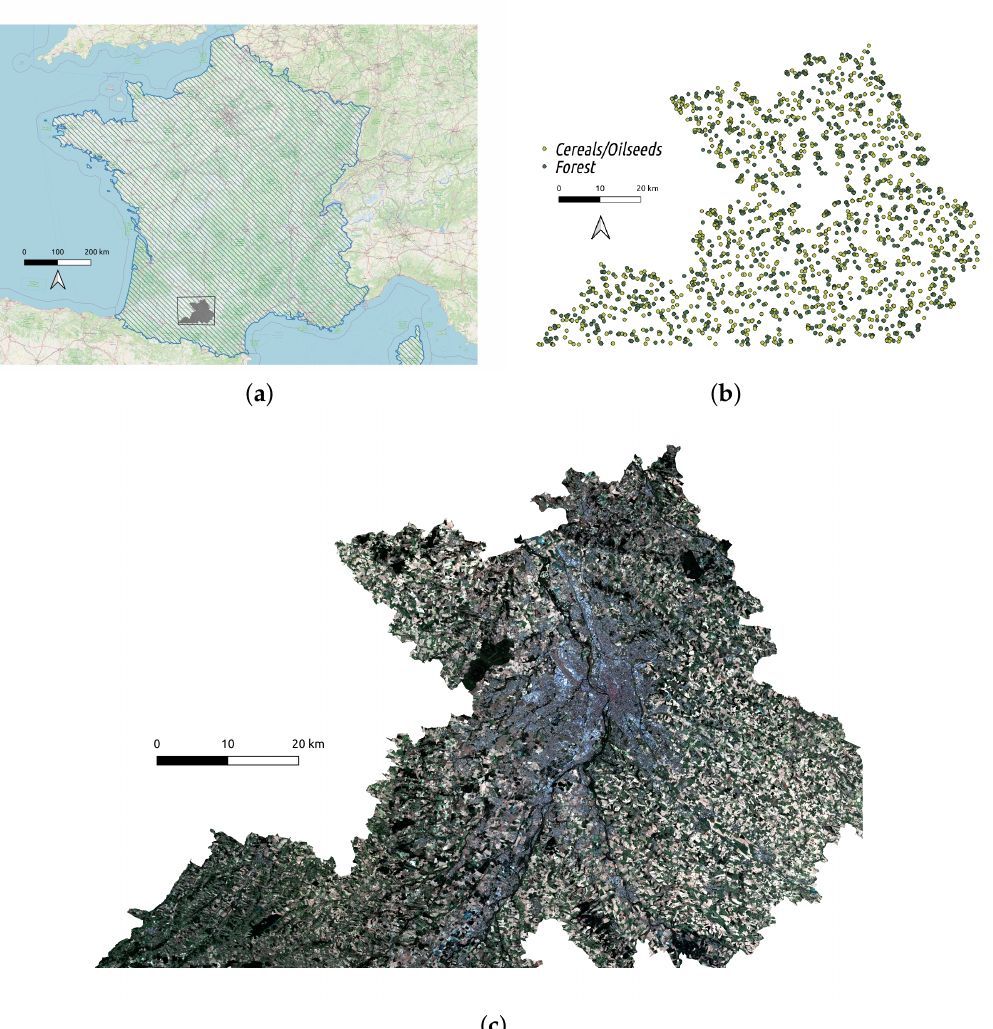
Figure 4. Haute-Garonne is located in the southwest of France ( a ). The spatial distribution of the land covers ( Cereals/Oilseeds and Forest ) considered as positive classes ( b ). The Sentinel-2 RGB composite obtained over the year 2019 ( c ).